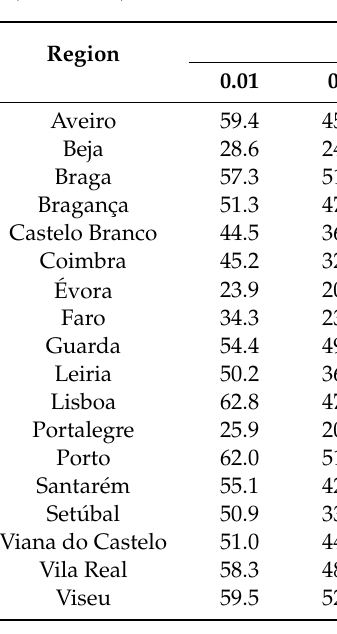
Table 2. Regional percentages of days with fires ≥ 0.01, 0.1, 1, 100, 500, and 1000 ha during the study period